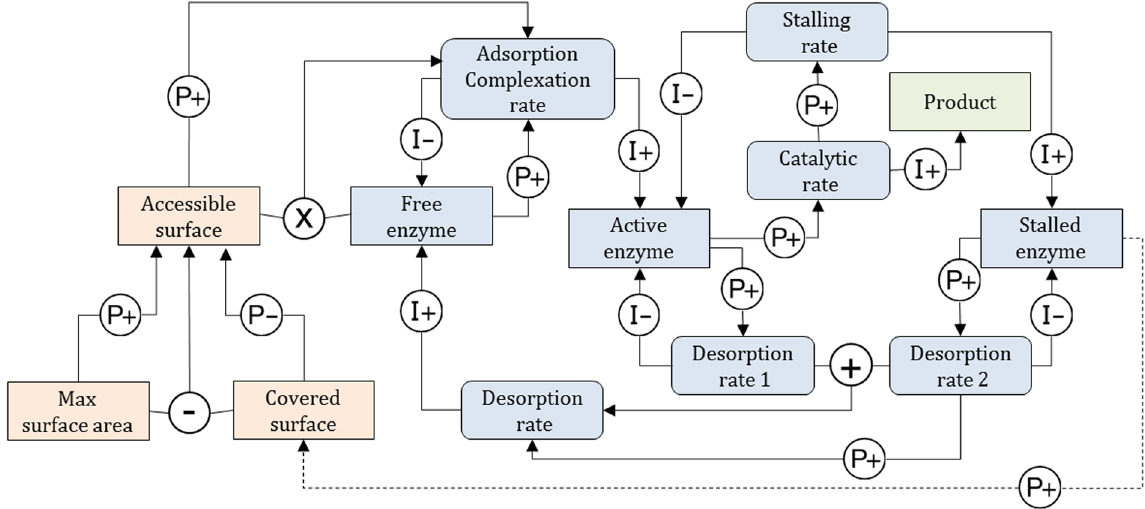
Figure 13. Qualitative Reasoning Model M3. Relationship with the numerical model (Eq. 3) is similar to M2 (Fig. 9). However, here Cellulose is replaced by a model fragment that computes Accessible surface from Max surface area and Covered surface . Orange denotes substrate-related quantities, blue-grey is used for enzyme related quantities, and green denotes product related quantities. Dashed line represents putative causal relation not